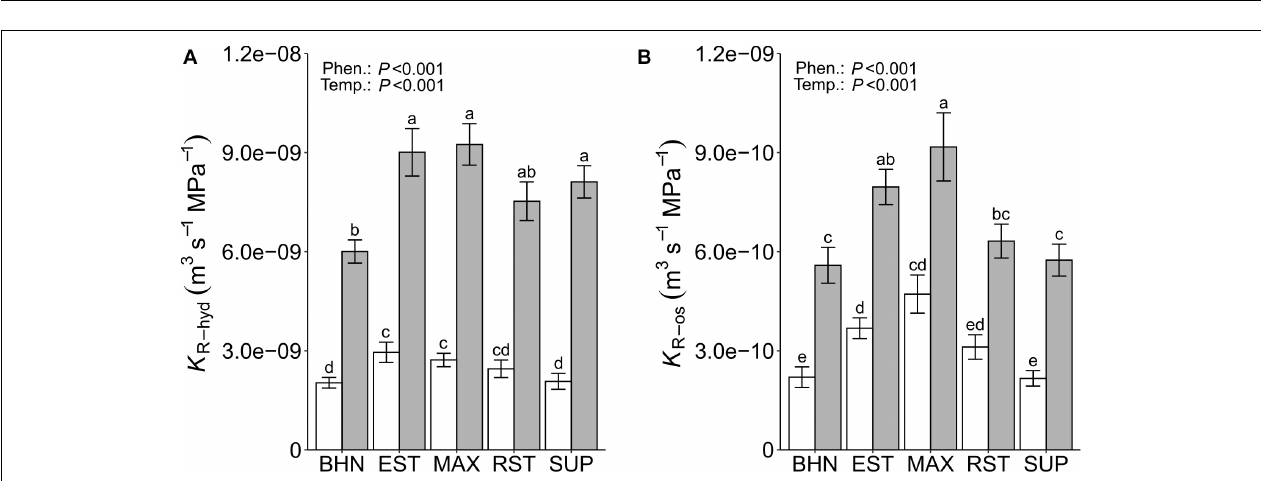
FIGURE 1 | Root hydrostatic ( Lp * hyd ; A ) and osmotic ( Lp * os ; B ) hydraulic conductivity on whole-root systems of four grafted rootstocks (Estamino, Maxifort, RST-04-106-T, and Supernatural) and one cultivar (BHN-589) grown under optimal (gray) and suboptimal (white) soil temperatures for 4 weeks. All rootstocks were grafted with BHN-589. Values are mean ± standard error ( A: n = 25–31; B: n = 23–31). Means followed by different letters are statistically different at P < 0.01.